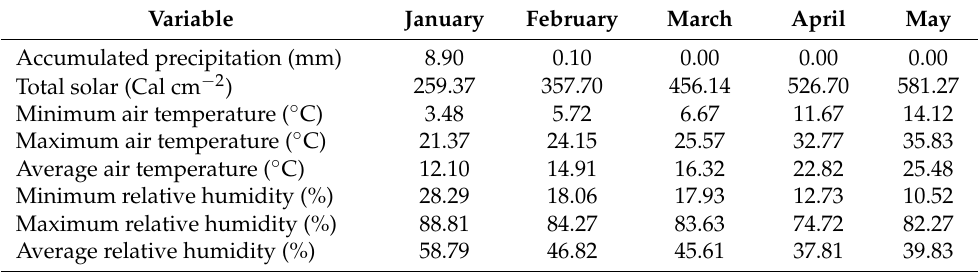
Table 1. Environmental conditions recorded during the experimental period between January and May 2021. Average monthly values of meteorological data recorded with an automatic weather station. Variable January February March April Accumulated precipitation (mm)